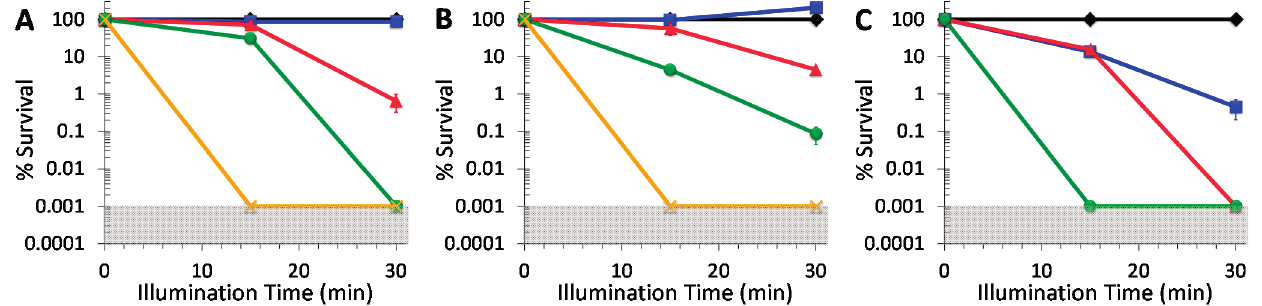
Figure 5. Photodynamic inactivation of ( A ) Candida albicans ATCC-90028, ( B ) Candida glabrata ATCC-15545, and ( C ) Cryptococcus neoformans ATCC-64538 as a function of DIMPy-BODIPY concentration and illumination time. Displayed is the % survival of the dark control ( ♦ ) and the light treated samples at 0.1 μ M ( ■ ), 0.5 μ M ( ▲ ), 1 μ M ( ● ),